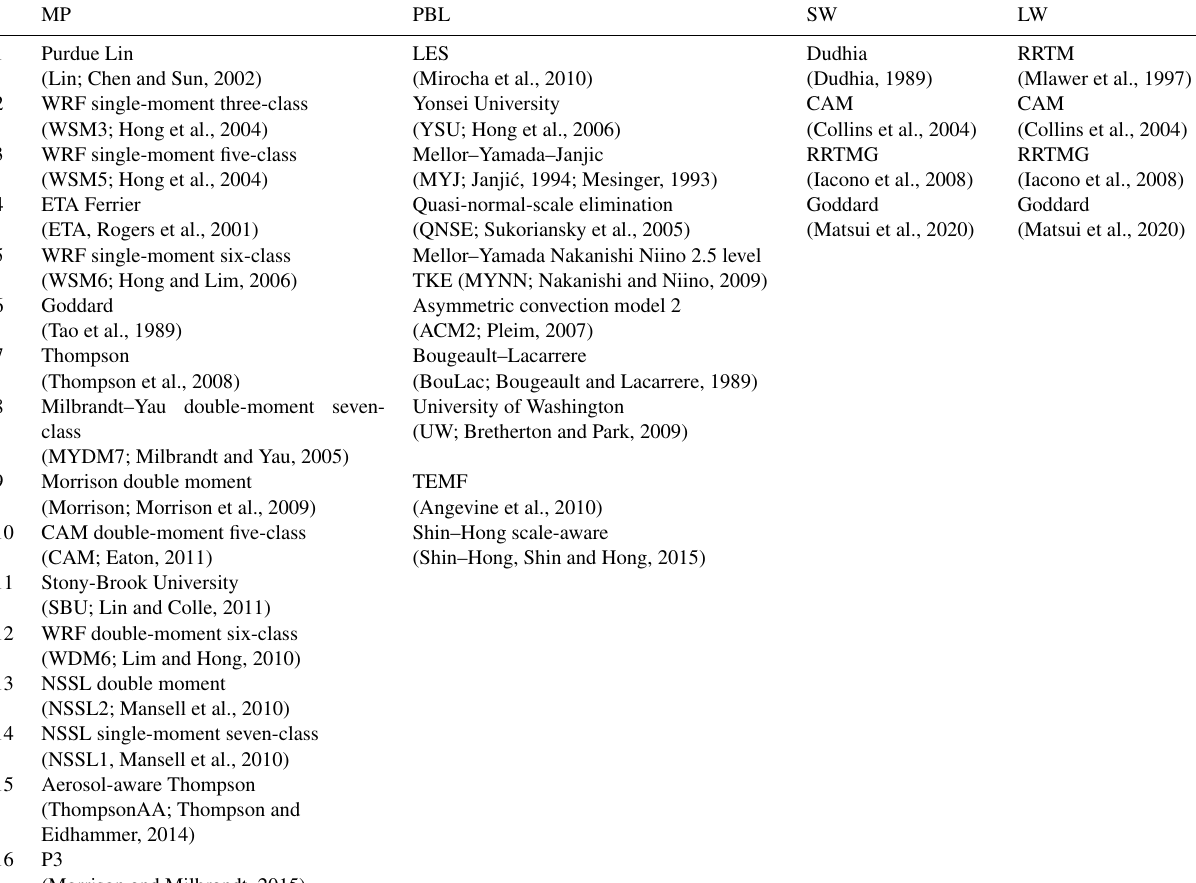
Table 2. List of microphysics (MP), planetary boundary layer (PBL), and shortwave–longwave radiation (SW–LW) schemes investigated in the 640 simulations; schemes that share rows are not specifically assigned to each other (except for